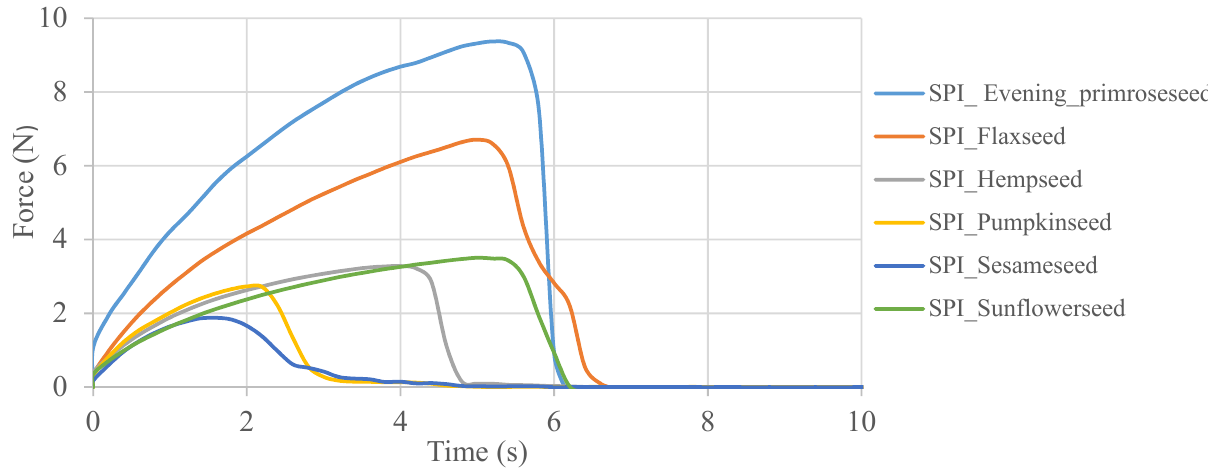
Figure 4. Force–time curves occurring during the tensile strength analysis of soy protein isolate–oilseed flour films. After comparing the properties of the films, significant differences were